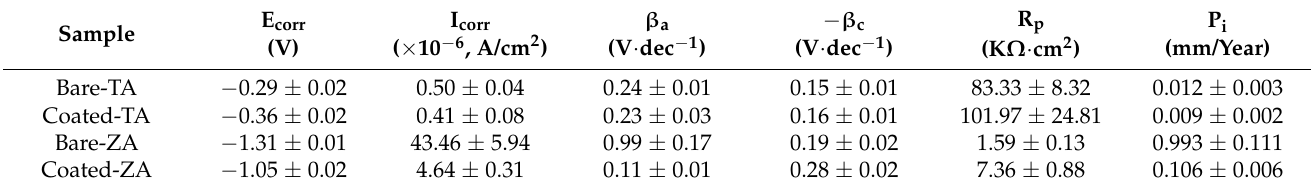
Figure 6. The equivalent electrical circuits are used to fit the impedance behaviors of ( a ) Bare ‐ TA, ( b ) Coated ‐ TA, ( c ) Bare ‐ ZA, and ( d ) Coated ‐ ZA. R.E.: reference electrode, W.E.: working electrode. As for the bare and coated ZA samples, three distinct humps shown in the Bode phase ‐ angle plot correspond to the three relaxation processes. The first time constant is located at a high frequency, which is due to the corrosion product generated after the